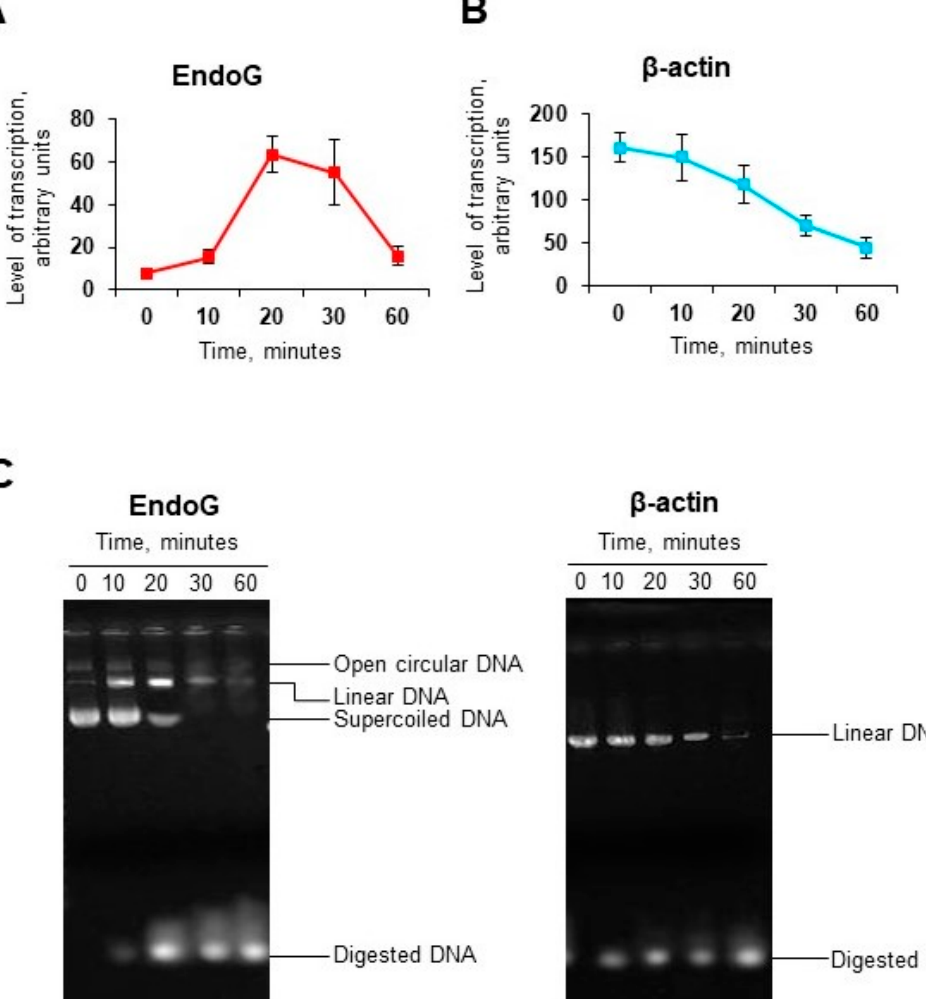
Figure 7. In vitro transcription of mouse EndoG ( A ) and mouse beta-actin ( B ) genes in plasmid constructs cleaved with recDNase I. mRNA expression was measured by real-time RT-PCR. Arbitrary units reflect coefficient of dilutions from 1:40 to 1:320 that were applied to the standard curve ( n = 4). ( C ) Gel electrophoresis shows digestion of pET29b-mEndoG and pTRI- β -actin plasmids by recDNase I (Pulmozyme).